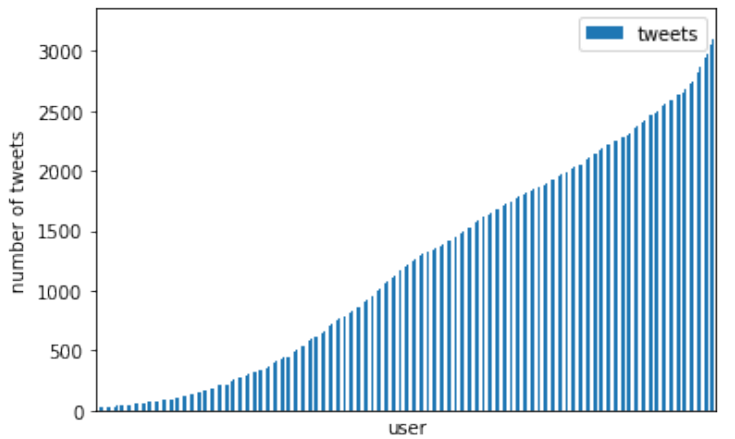
Figure 5. The distribution of tweet numbers over users. Each bar on the x-axis represents the user. The y-axis represents the number of the users’